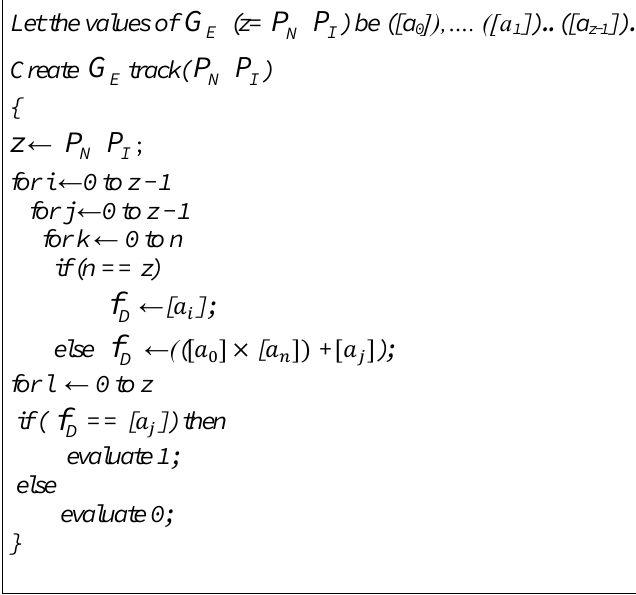
Figure 5. Slot allocation using Galois